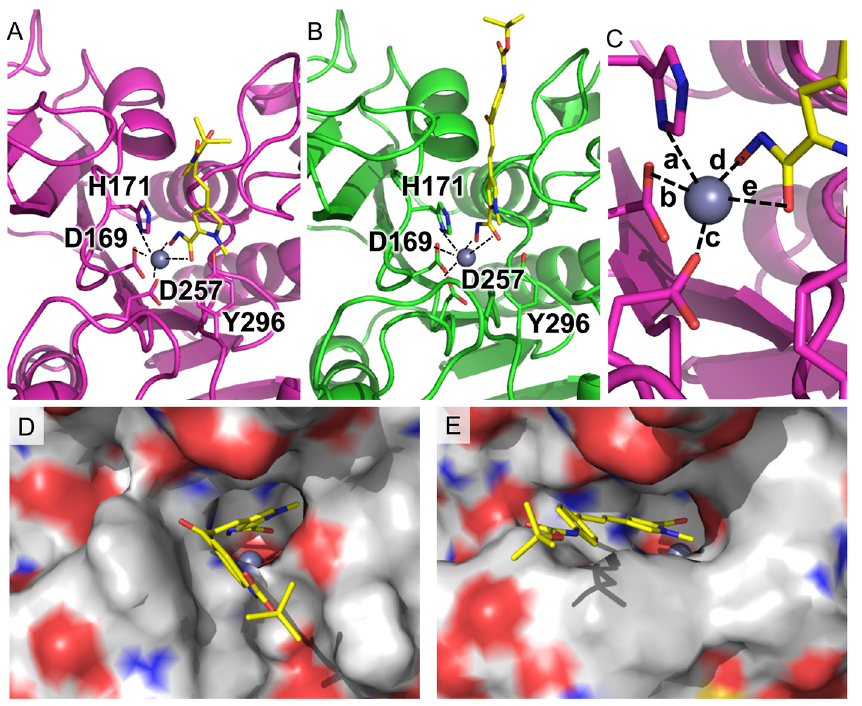
Fig 4. Compound MC2776 docked to the KDAC1 protein. (A) in the B . malayi protein and (B) in the H . sapiens protein. MC2776 is shown as yellow stick model along with important residues for ligand binding. (C) shows a close-up view of the zinc-centered square based pyramid, Distances for these are shown in Table 2. (D) and (E) show the rendered surface models of the cartoon representations from (A) and (B).